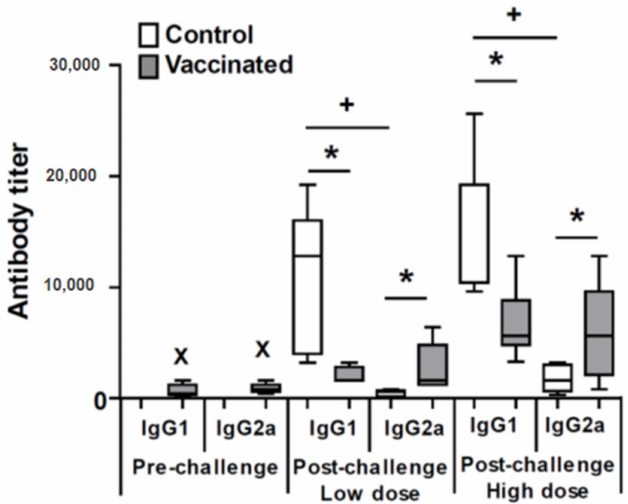
Figure 2. Humoral responses against Leishmania parasites. The reciprocal end-point titers of the IgG1 and IgG2a anti-leishmanial subclasses were analyzed by ELISA 12 weeks after the inoculation of the Li ∆ HSP70-II attenuated line (pre-challenge; n =13; L. infantum soluble leishmanial antigens (SLA)), 14 weeks after challenge (5 × 10 4 promastigotes; low dose n = 5) and 11 weeks after challenge (5 × 10 6 promastigotes; high dose n = 8) with L. amazonensis using SLA of this last species. Data are represented as whisker (min to max) plots and represent one out of two experiments with similar results. X ( p < 0.05 statistical differences among titer from the pre-challenge and both post-challenge mice; * ( p < 0.05 between titers from control and vaccinated groups); + ( p < 0.05 between IgG1 and IgG2a form animals of the control group) analyzed by Kruskal-Wallis